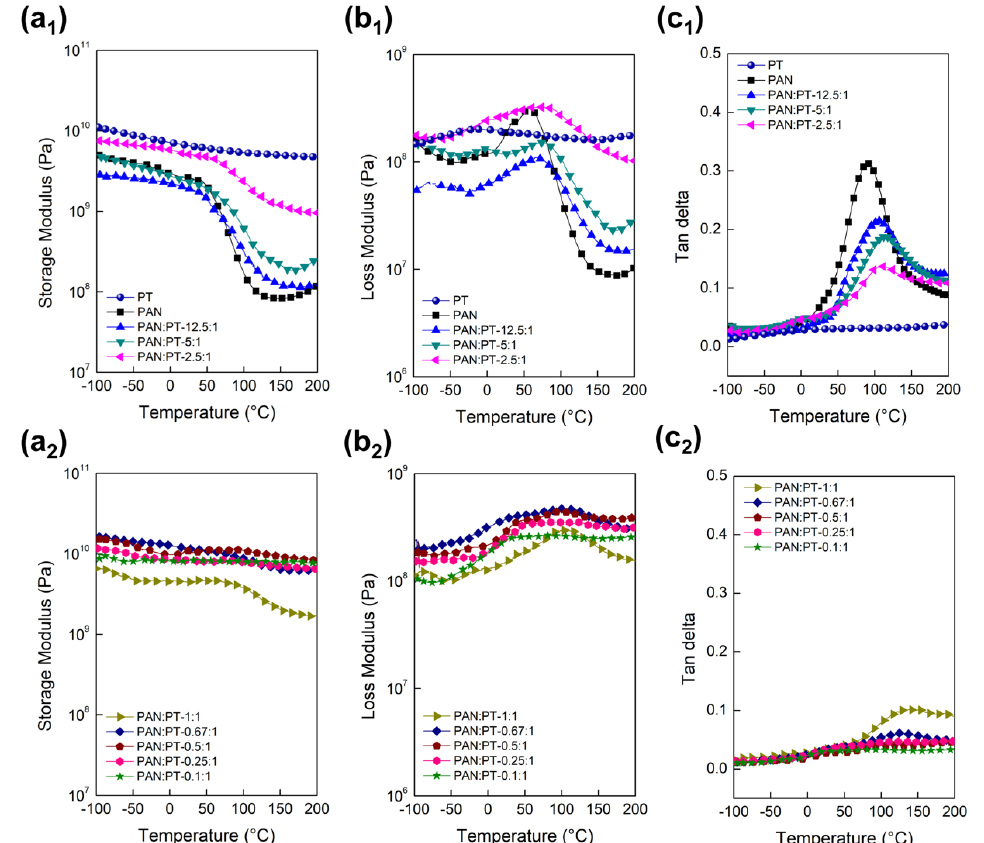
Figure 11. ( a 1–2 ) Storage modulus, ( b 1–2 ) loss modulus, and ( c 1–2 ) tan δ of PT BP, PAN films, and hPBPs with different PAN:PT ratios as a function temperature at 1 Hz. For clarity, data is split onto two plots for each measured